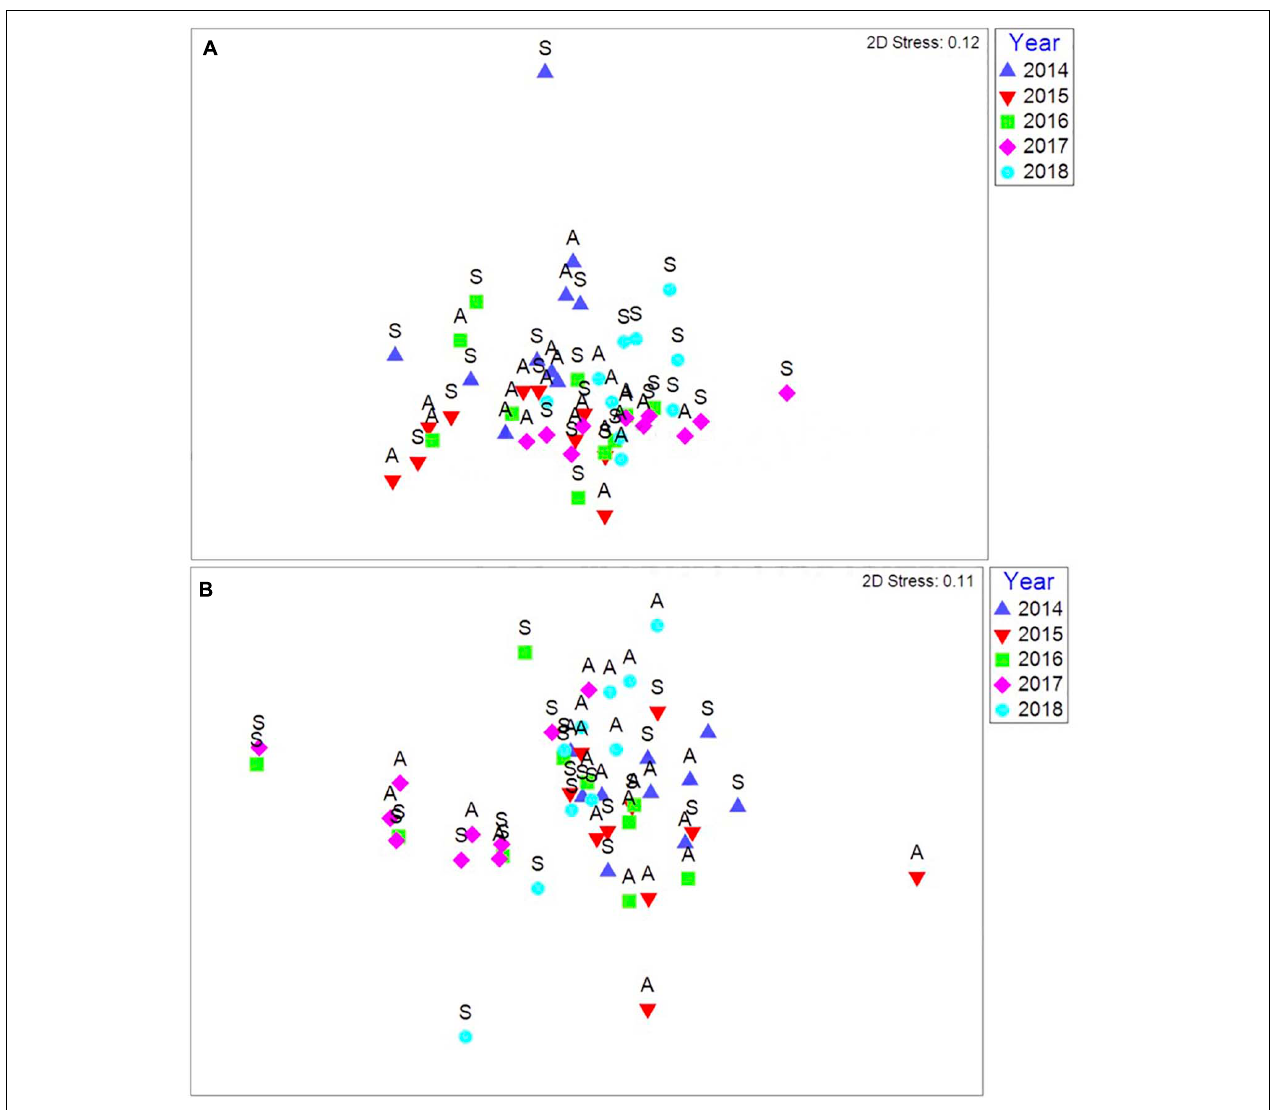
FIGURE 7 | (A) Multi-dimensional scaling ordination of communities diversity per season (S, Spring; A, Autumn) from immediately after the storm events in spring 2014 until autumn 2018 in the low eulittoral at St. Ives, (B) Multi-dimensional scaling ordination of communities diversity per season (S, Spring; A, Autumn) from immediately after the storm events in spring 2014 until autumn 2018 in the mid eulittoral at St. Ives. Based on Bray Curtis similarity coefficient, non-standardised data and square root transformed